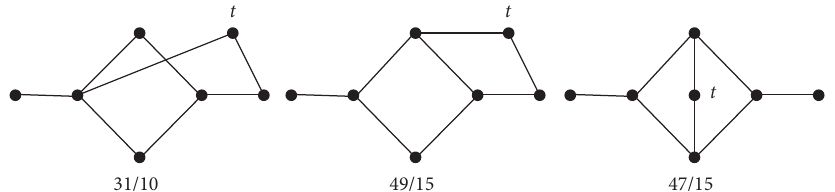
Figure 7: The graphs related to Subcase 2.1 of Theorems 3 and 4.